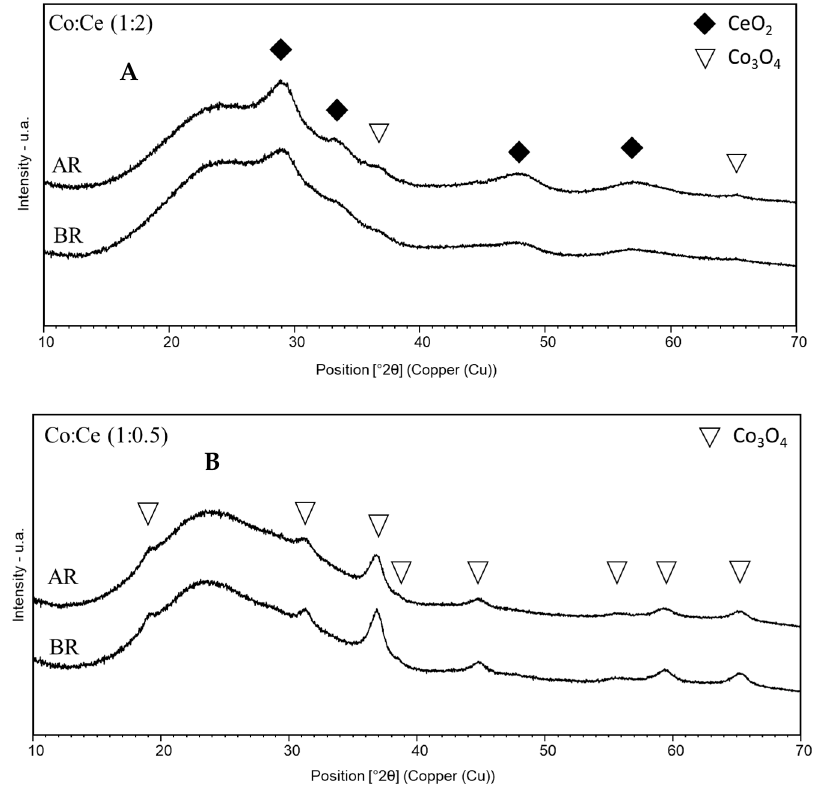
Figure 4. Wide angles X-ray diffraction patterns of the Co:Ce (1:2) catalyst before and after reaction ( A ) and Co:Ce (1:0.5) catalyst before and after reaction ( B ). The TEM images show well-ordered 2D-hexagonal p6mm pore organization of SBA- 15. The ordered pore channels were well-preserved both after the incorporation of Co and Co–Ce and after the n -hexane oxidation reaction. The darker areas correspond to the crys- talline oxides. The Energy Dispersive X-ray (EDX) analyses were performed with all stud- ied samples and Co and Ce element mapping (Figures S1–S3 from Supplementary Mate- rials) confirmed uniform distribution in the CoCe samples (Table 2). From TEM images